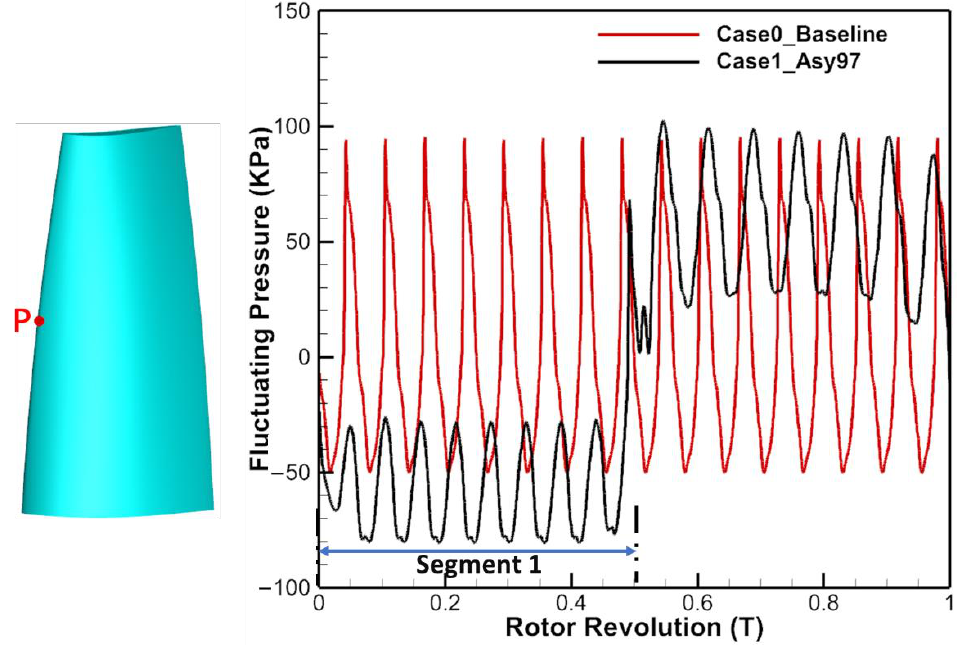
Figure 7. Schematic diagram of monitoring point P and the time histories of the fluctuating pressure.